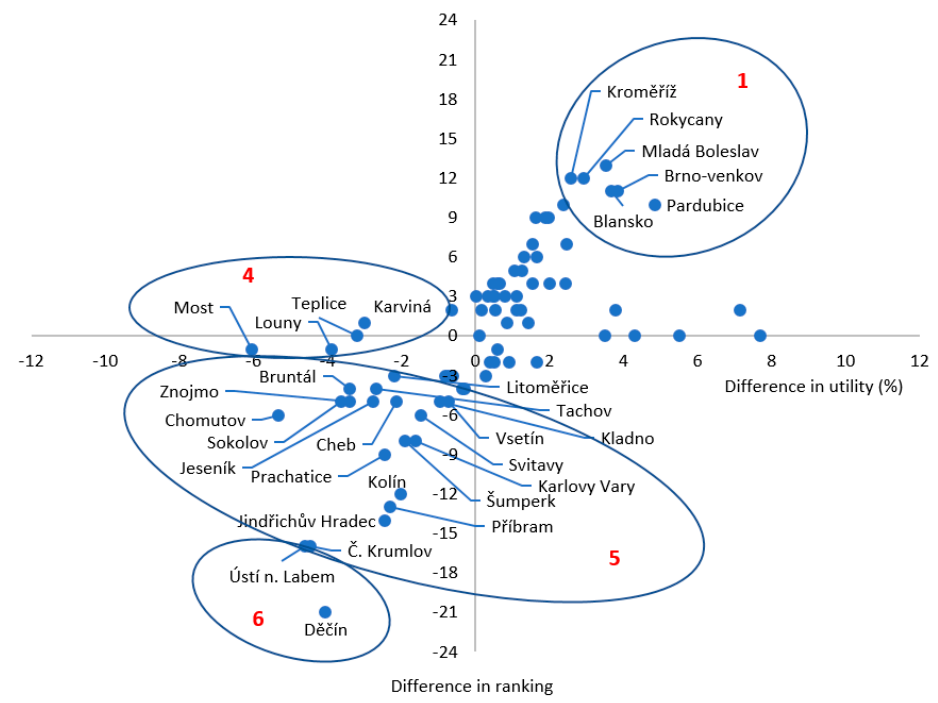
Figure 4. TOPSIS method, difference in ranking, and utility in weight assignment districts of the Czech Republic. Figure 4 reflects the results of using the TOPSIS method of analysis (we present only the results for groups 1, 4, 5, and 6). In the case of group 1, districts with the highest in- crease in the Health Index value are indicated, showing the highest positive change in ranking is larger. In the case of group 2, the increase in the Health Index value shows a different degree of change in the ranking of districts. In the case of group 3, there was an improvement in the Health Index value and a simultaneous decrease in rankings for a very small number of districts. The other three groups of districts (4 to 6) showed a de- crease in the Health Index value and are characterized by a decrease in the Health Index value without a decrease in rankings (group 4). In the case of group 5, the Health Index value decreased and with it the ranking, while in group 6, the decrease in the Health Index value also reflects in the most significant decrease in the ranking of districts (D ěč ín and Ústí nad Labem). Despite this similarity in the characteristics of the groups of districts when comparing the two methods, the TOPSIS method generally results in a lower nega- tive reduction in the Health Index than the WSA method. 4.3. Assessment of the Key Determinants and Indicators of the Health Position of Communities The third research area focuses on identifying the key determinants and indicators of health positions that underlie health inequalities. We analyzed those districts from which we deliberately selected districts belonging to the same groups, represented by the highest and lowest Health Index values calculated by both the WSA and TOPSIS methods with weightings (see Table 3; Figure 2). To identify the key determinants and indicators (outcomes) of the health condition of communities that also reflect both positive and neg- ative inequalities, we used a decomposition of the Health Index into areas (Table 4, Figure 3) and, within areas, into sub-indicators.